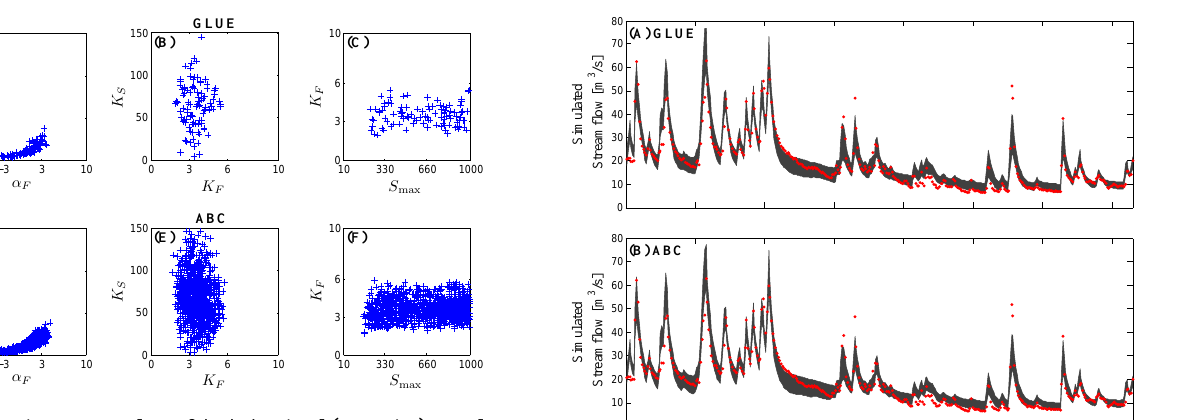
Fig. 10. Bivariate scatter plots of the behavioral (posterior) samples of three different (randomly selected) hmodel parameter pairs us- ing GLUE (top panels) and ABC (bottom panels): (A) α F − Q max , (B) K F − K S , and (C) S max − K F . The scatter plots derived with both methods are in close agreement but demonstrate an important difference in sampling density. The computational budget of GLUE was limited to about 3 days, which has resulted in 100 behavioral solutions.